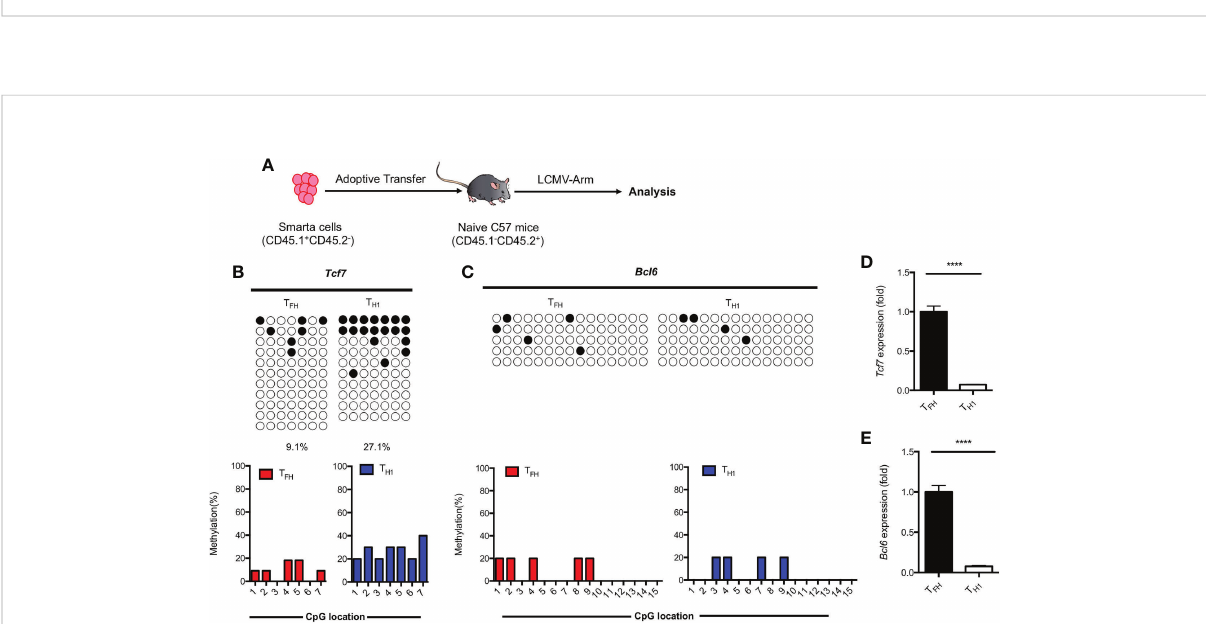
FIGURE 5 Methylation of Tcf7 Locus is associated with the differentiation of T FH cells during acute viral infection. (A) Procedure of experiment. 2 × 10 4 naive SMARTA cells were adoptively transferred into naive C57BL/6 mice, the chimeras were infected with LCMV Armstrong strain subsequently. (B, C) The virus experienced T + SLAM low CXCR5 + ) and T + SLAM high CXCR5 - ) cells were sorted at day 7 after infection with FH (CD45.1 H 1 (CD45.1 LCMV Armstrong strain. The isolated genomic DNA puri fi ed from these two subtypes were subcloned into pMD19-T TA vectors for subsequent sequencing. The graphical summary of CpG islands of Tcf7 (B) and Bcl6 (C) were performed with bisul fi te sequencing. (D, E) The transcriptional expression of Tcf7 (D) and Bcl6 (E) were measured by RT-PCR. Normalized to their expression in T FH cells. The horizonal lines were corresponding to the colonies selected for sequencing. Filled black circles indicate methylated cytosine, open white circles indicate nonmethylated cytosine. P value was calculated by unpaired two-tailed Student ’ s t test. Error bars indicate mean ± SEM. **** P <